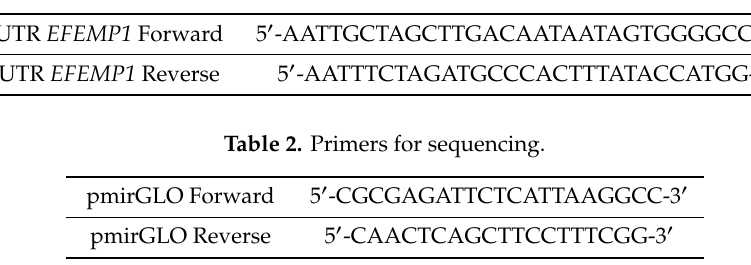
Table 2. Plasmid DNA with the correct integrated insert was amplified starting from the corresponding backup colonies and extracted with NucleoBondXtra Midi Plus kit (Macherey-Nagel, Düren, Germany). Table 1. PCR primers.